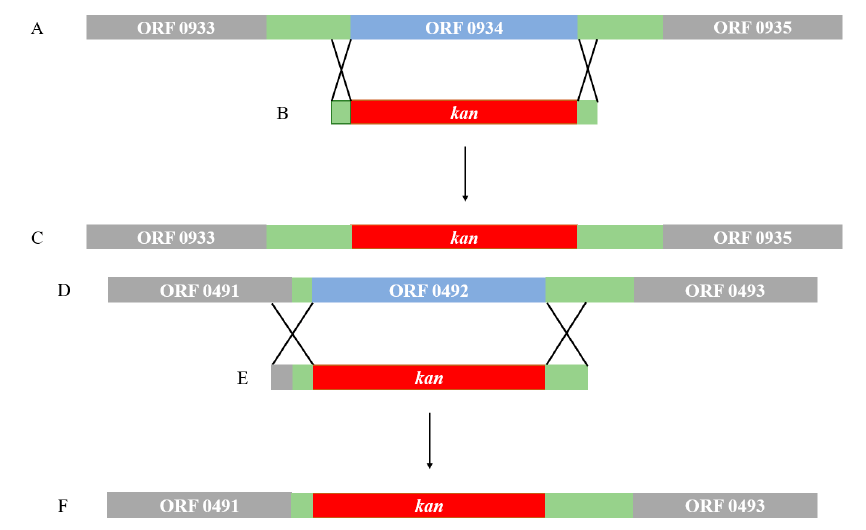
Figure 11. The construction of the two genetic knockouts ∆ ORF 0934 and ∆ ORF 0492. A and D show the locations of the target genes (ORFs 0934 and 0492 in blue areas), B and E are the kanamycin resistance gene cassettes showing the 60 bp regions at each end homologous to the target genes to be deleted, and C and F show the genetic structure of the knockouts. The green zones indicate the intergenic regions. Cross symbols between A and B, and D and E indicate the locations of the 60 bp homologous sequences (Table 2). Kan indicates the kanamycin resistance gene in red zones. Grey areas indicate the flanking ORFs.